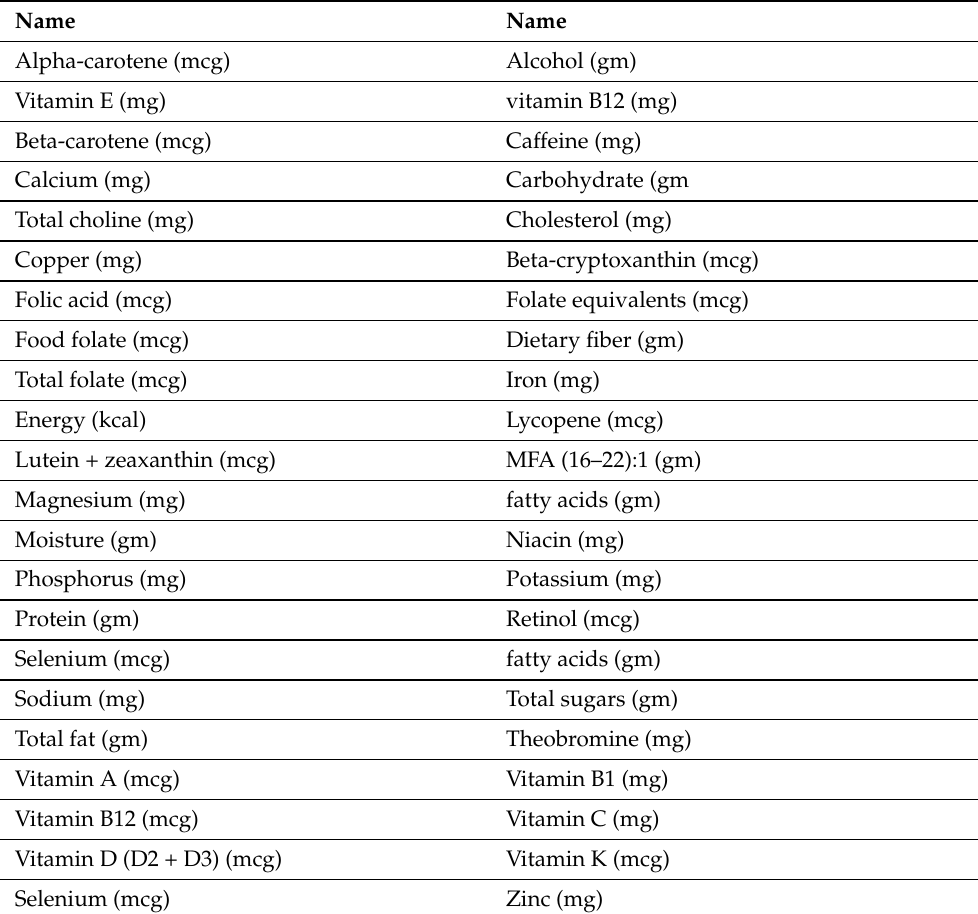
Table 2. Dietary variables examined—system input